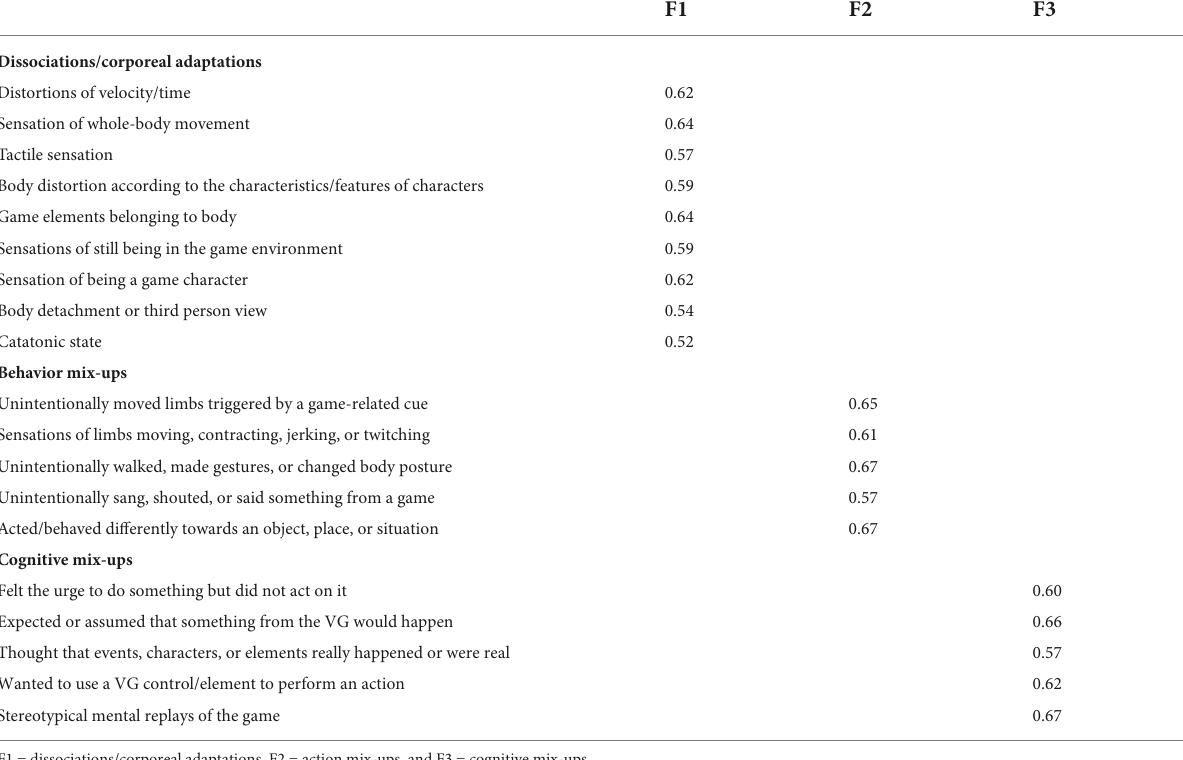
TABLE 5 Standardized factor loadings for items in the dissociations/mix-ups dimension.